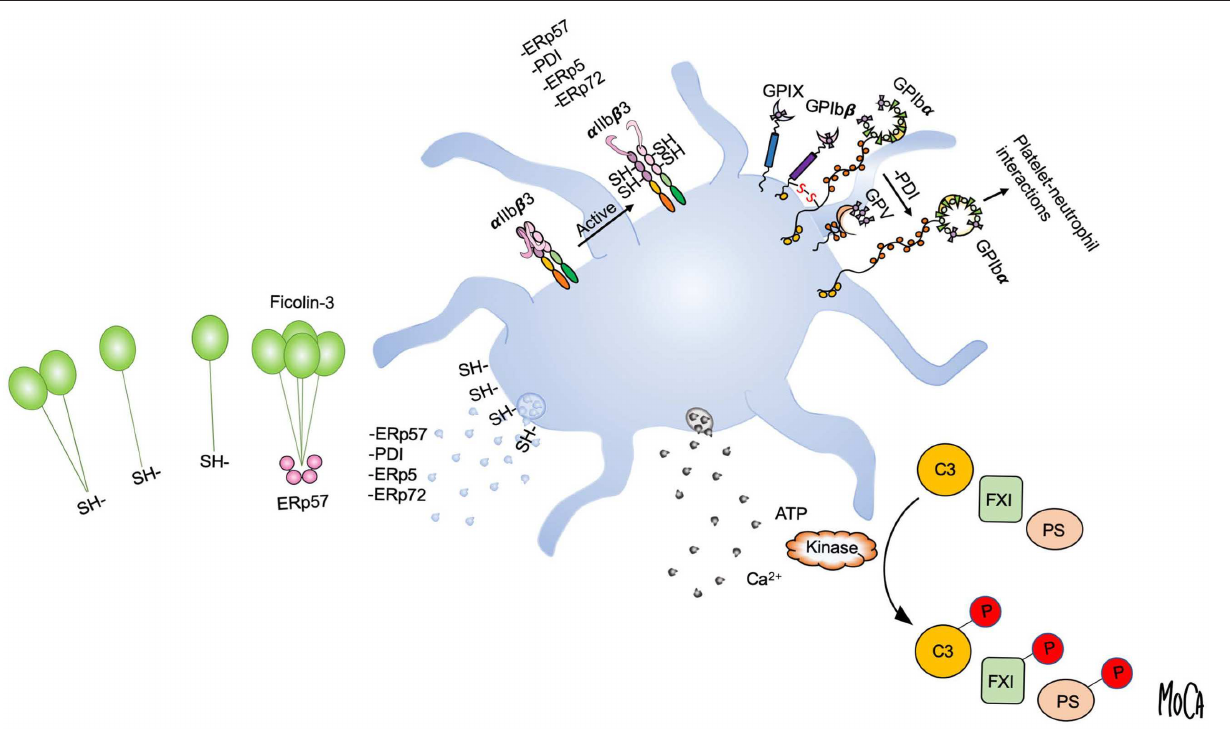
FIGURE 3 | Post-translational protein modifications in the platelet microenvironment. Platelet activation and granule release create a microenvironment in which post-translational protein modifications can occur in the extracellular environment, as exemplified by disulfide bond rearrangement and phosphorylation. Platelet intrinsic reductase activity leads to exposure of free thiols and may provide a regenerating system for thiol isomerases. Platelets release vascular thiol isomerases that rearrange allosteric disulfide bonds in protein substrates. Multiple thiol isomerases are required for full α IIb β 3 activation and platelet aggregation. Platelet-derived ERp57 cleaves multimeric ficolin-3 by disulfide bond reduction to limit platelet recognition by the lectin pathway (left). PDI released from platelets reduces disulfide bonds in GPIb α of the GPIb-IX-V complex to increase GPIb α -mediated platelet-neutrophil interactions (upper right). Exocytosis of platelet dense granules elevates the local ATP and Ca 2 + concentrations. Substrates including complement C3, coagulation factor XI (FXI), and protein S (PS) can then be phosphorylated by platelet-derived or circulating kinases (lower